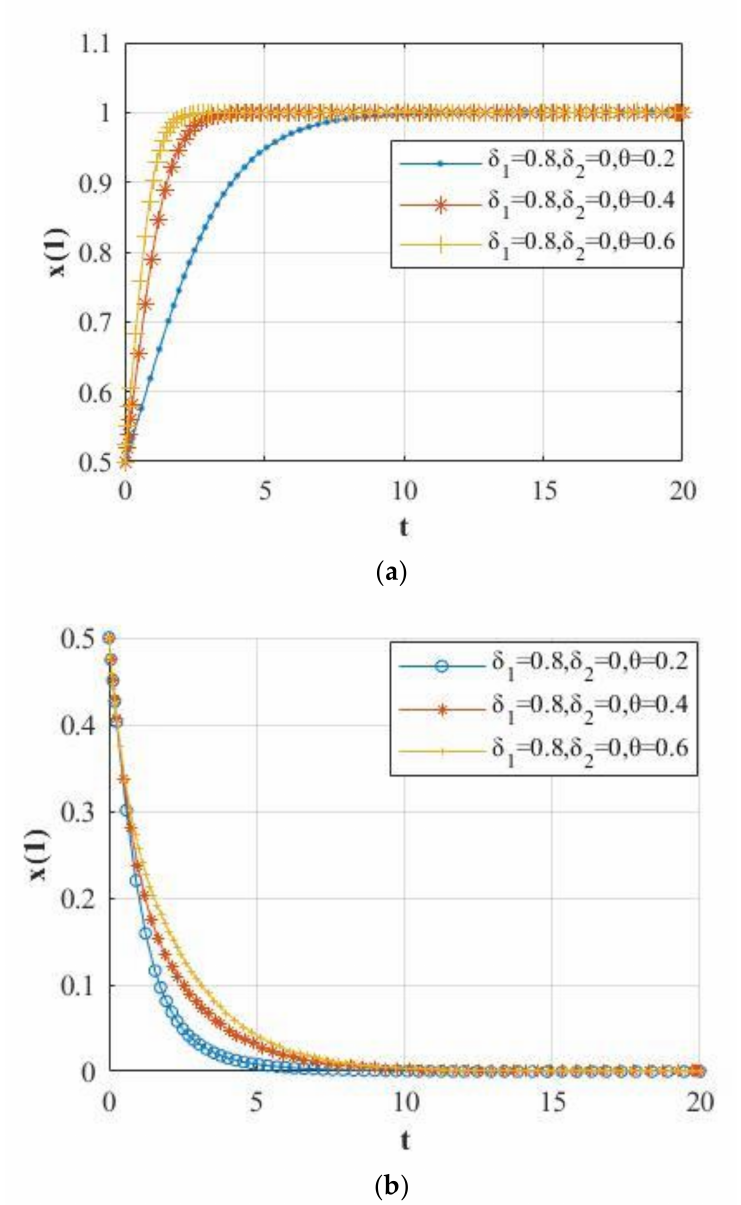
Figure 7. ( a ) While δ 1 = 0.8 and changing θ , evolution diagram of government’s supervision option. ( b ) While δ 1 = 0.8 and changing θ , evolution diagram of platform’s supervision option. (2) When platform holds altruistic preferences, δ 2 (cid:54) =